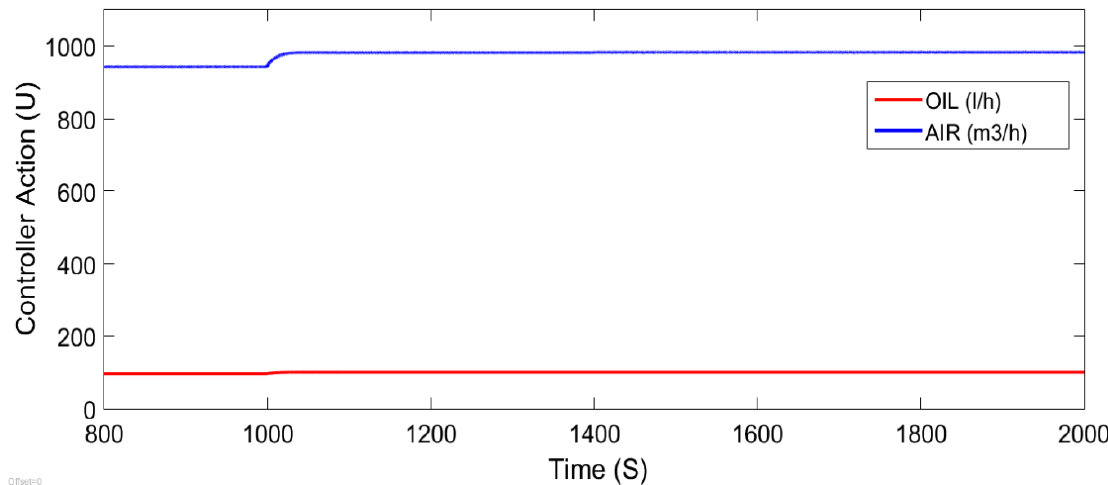
Figure 7. Controller efforts of H 2 -SFC.